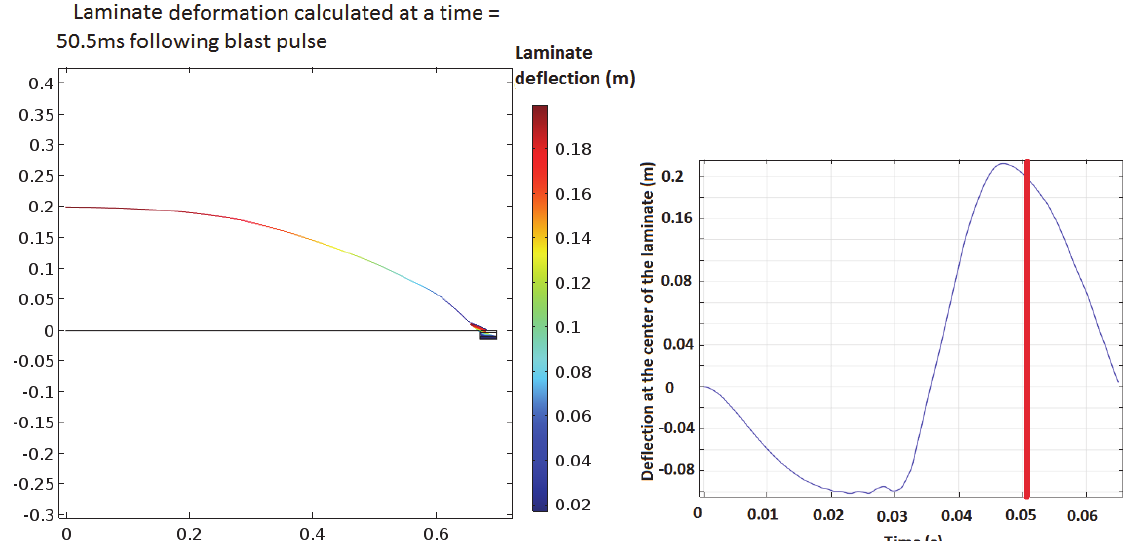
Fig. 5c: laminate deformation calculated at a time = 50.5ms following the beginning of the pulse. We observe a nearly parabolic deflection profile, with a maximum deflection amplitude of ~